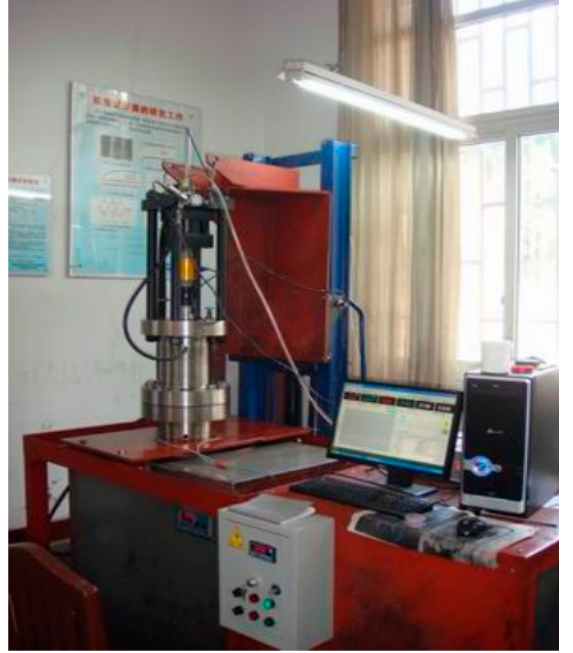
Figure 1. Briquette specimens.